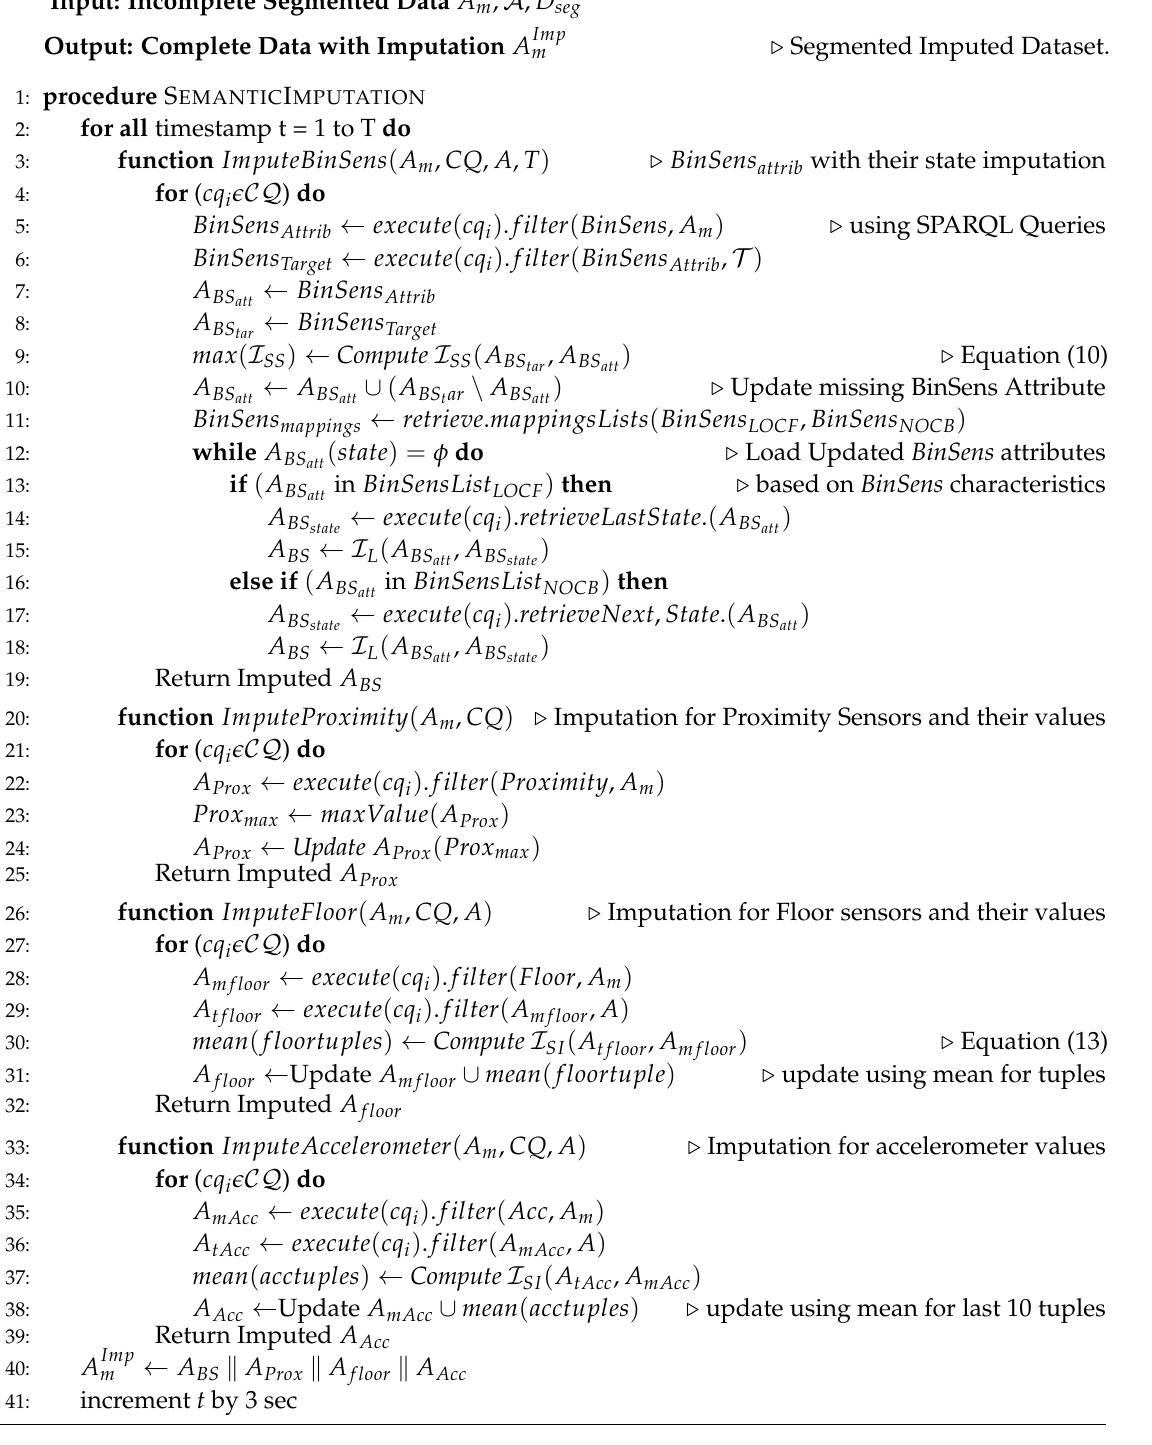
Algorithm 1 Semantic Imputation Using I SS ( A m ) , I SI ( A m ) , and I L ( A m ) through SPARQL